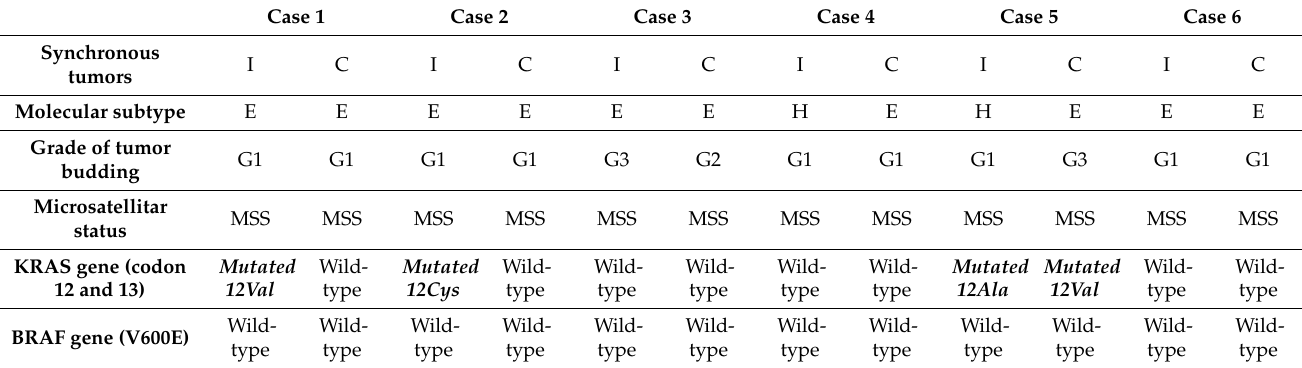
Table 3. Molecular subtyping, grade of tumor budding and status of KRAS and BRAF